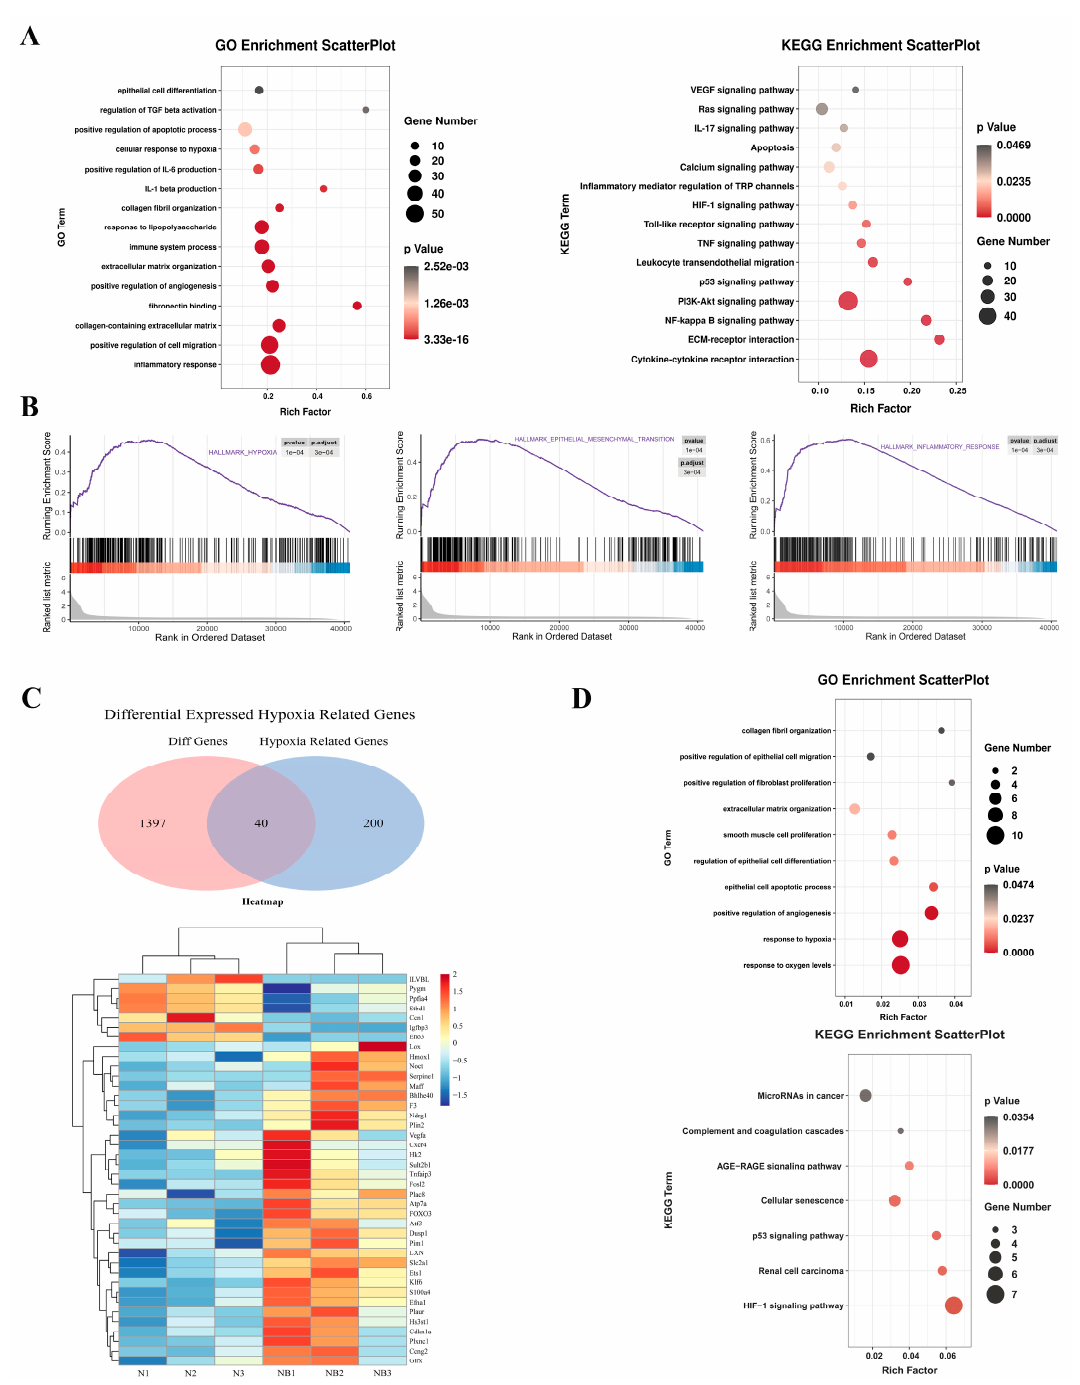
Figure 2. RNA sequencing assays to identify potential pathways and genes of bladder fibrosis after SCI. ( A ) GO and KEGG analyses showed enrichment of DEGs in epithelial cell differentiation, inflam- matory response, HIF-1 α pathway and cytokine–cytokine receptor interaction. ( B ) GSEA revealed enhanced hypoxia, EMT and inflammatory response pathway. ( C ) Heatmap of 40 differentially expressed HRGs. ( D ) GO and KEGG analyses showed enrichment of differentially expressed HRGs in response to oxygen levels and the HIF-1 α